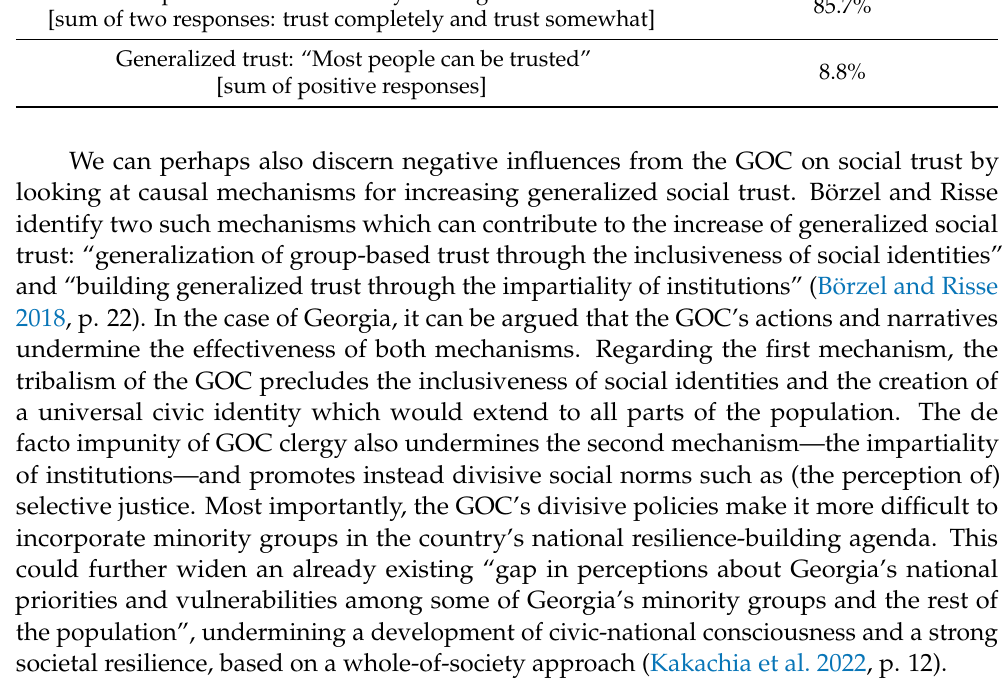
Figure 2. Do you support or oppose Georgia joining the EU? (IRI 2022, p. 68). The GOC’s recent radicalization, however, undermines the fundamentals of Geor- gia’s identity building. In the long term, this could result in weakening of permissive con- sensus in the religious section of the population on the country’s European integration and turn it into a constraining dissensus. 4 Georgian society is already quite fragmented along political, social, and cultural lines, and European integration is among the very few denominators of national unity. Its weakening could further upset the balance in Georgian society, strengthening group-based tribalism and undermining the creation of a civic identity that transcends narrow ethnic, religious, and other group-based boundaries. All this will certainly further undermine Georgia’s societal resilience, the ability of Georgian society to cope with major crises and disruptions in an effective way. 4. Discussion In this article we examined how the creeping radicalization of the GOC could undermine Georgia’s societal resilience. We identified two such mechanisms: the weakening of general- ized social trust and the damage to the process of civic-national identity building through dis- tancing from the idea of Georgia’s European integration. This can have long-term unintended consequences not only for Georgia’s foreign and domestic policy but also for the GOC itself, which require more exploration both from academic and policy perspectives. 0